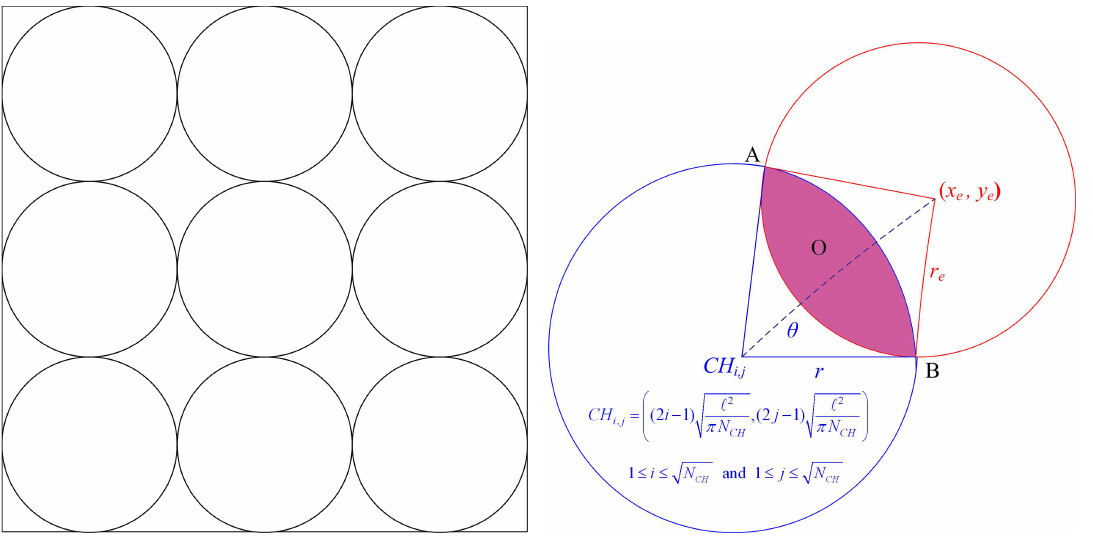
Figure 5. The geometric illustration of cluster distribution; an ideal distribution of clusters (left), the infected region O of a cluster